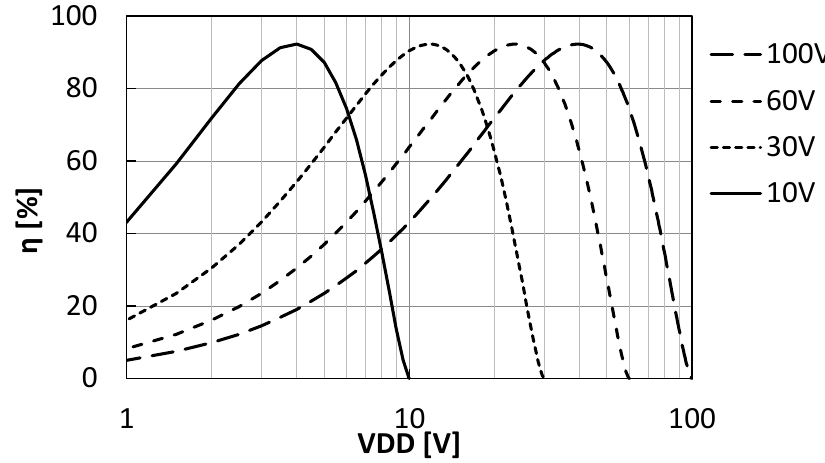
Figure 4. PCE η vs. V DD at V A = 10 V, 30 V, 60 V, and 100 V.